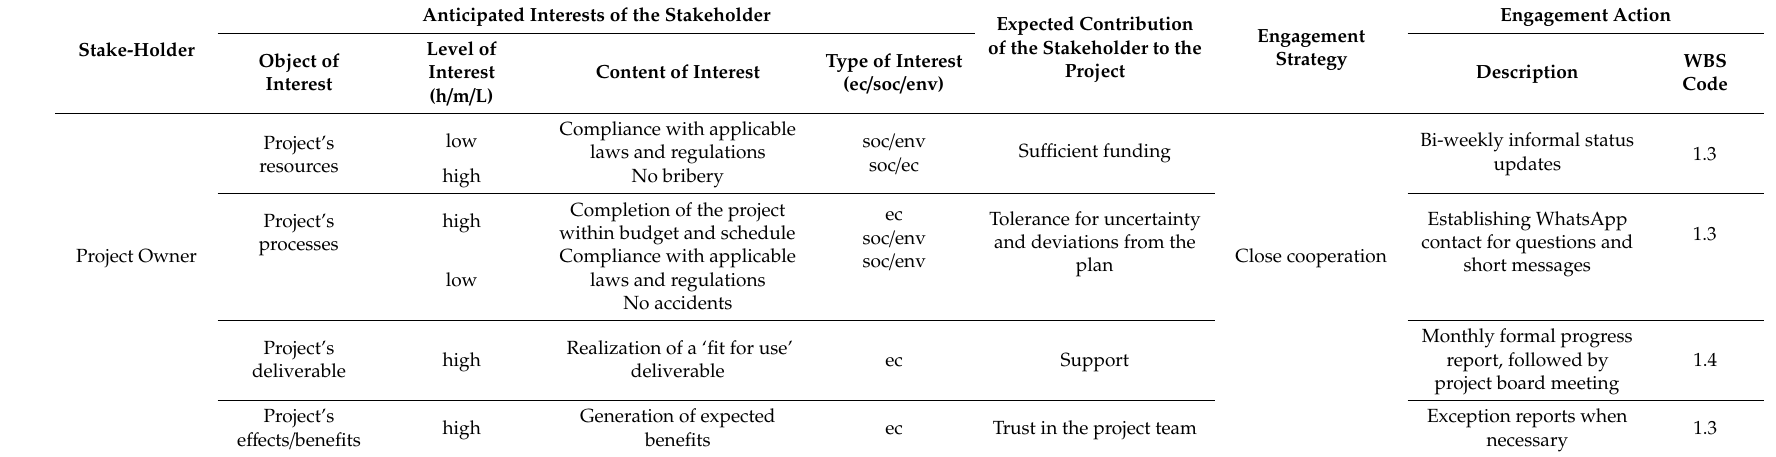
Table 7. Proposed framework for analysing stakeholder’s interests and documenting stakeholder engagement